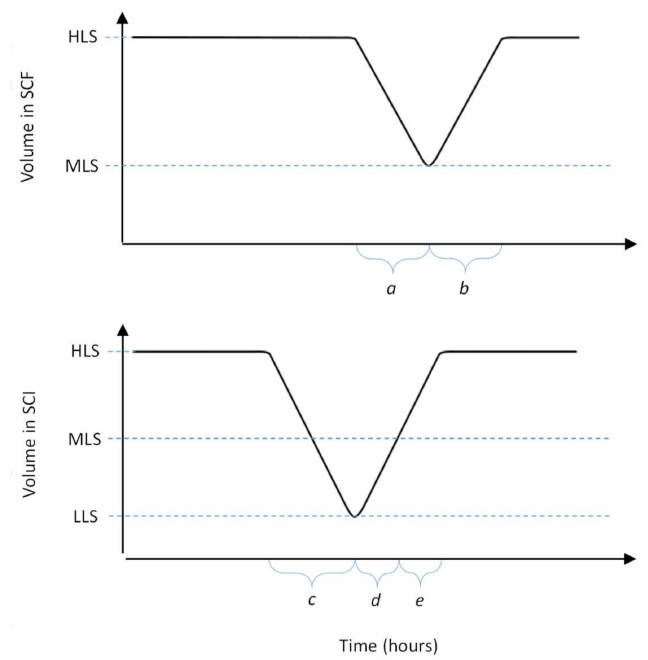
Figure 2. Volume changes in the SCF and SCI reactors during operation, where the volume changes are due to cycling events. Each event involves removal of liquid and subsequent refilling of